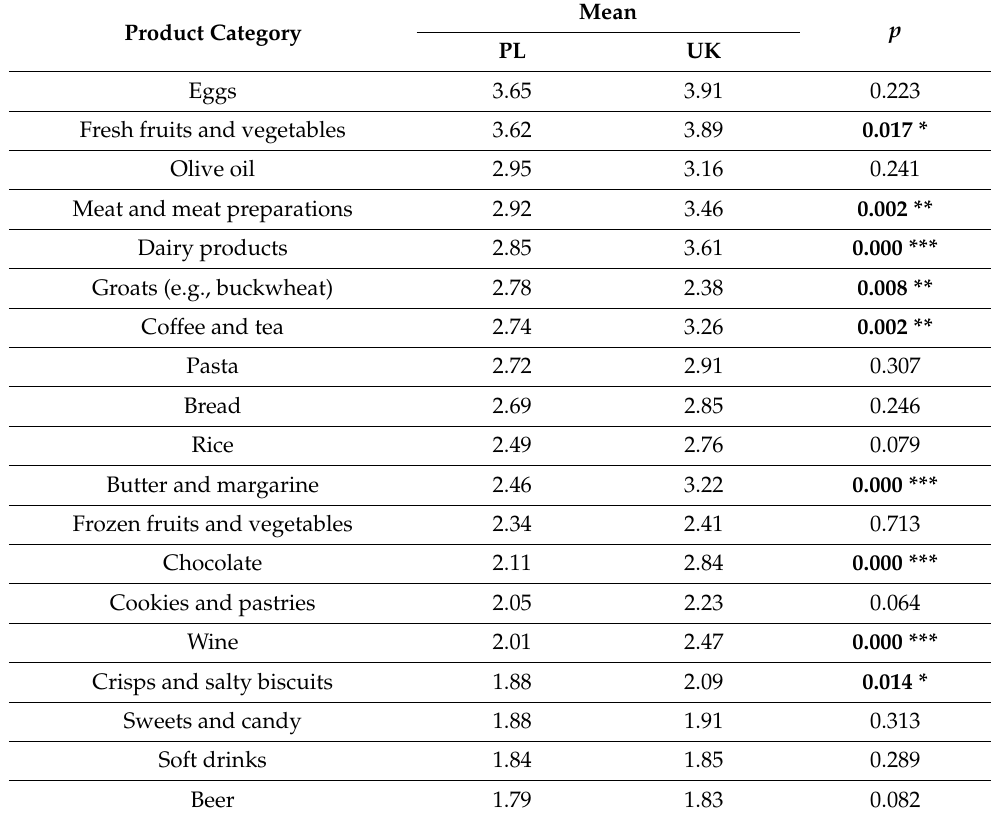
Table 6. The differences in frequency of purchasing certain organic product categories between respondents from PL and the